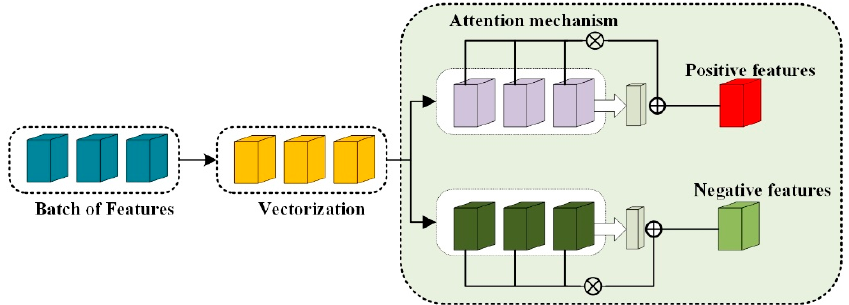
Figure 4. The attention block for the proposed CNN-LSTM network.